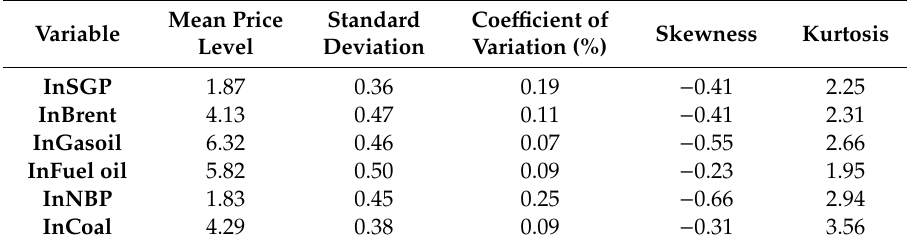
Table 1. Descriptive statistics of natural logarithm levels over